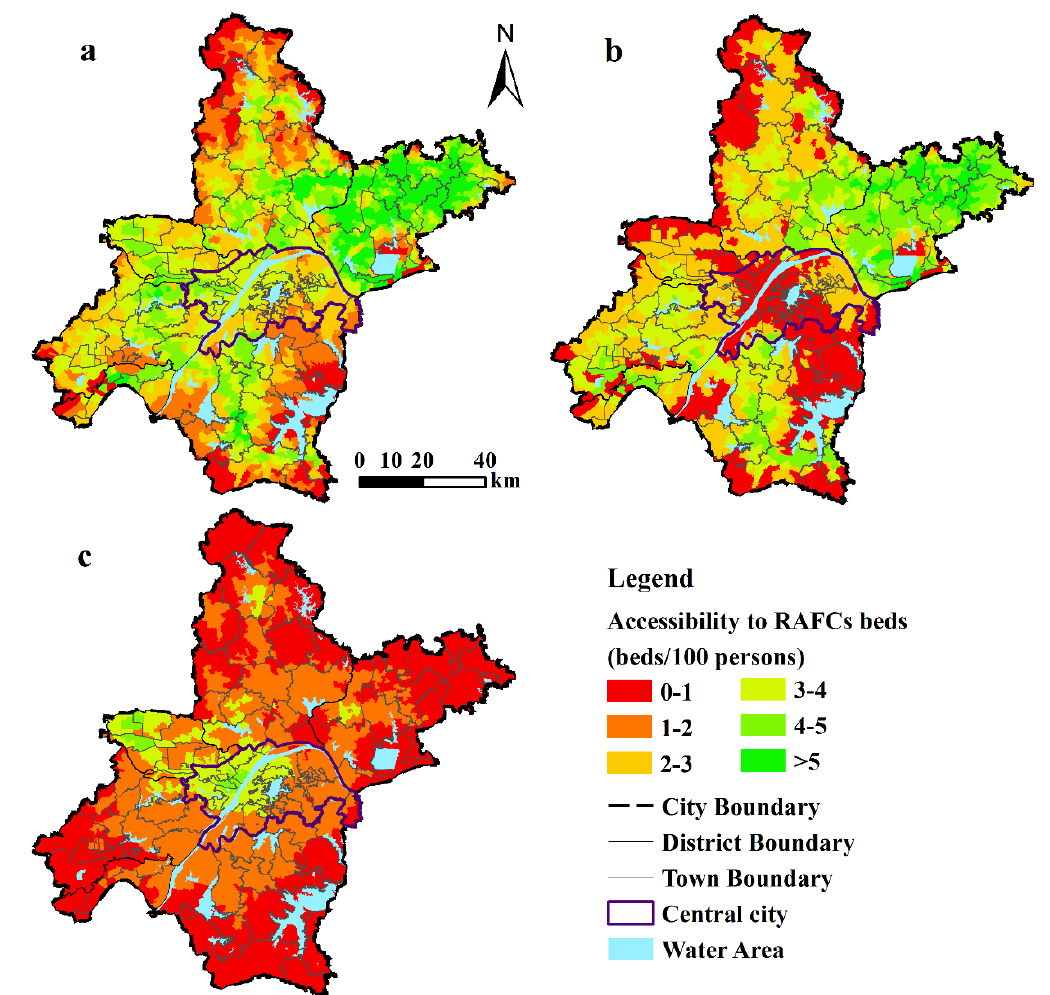
Figure 5. Spatial accessibility to RACFs in Wuhan by the MCSG2SFCA method. ( a ) Accessibility to all RACFs; ( b ) Accessibility to public RACFs; ( c ) Accessibility to private RACFs.